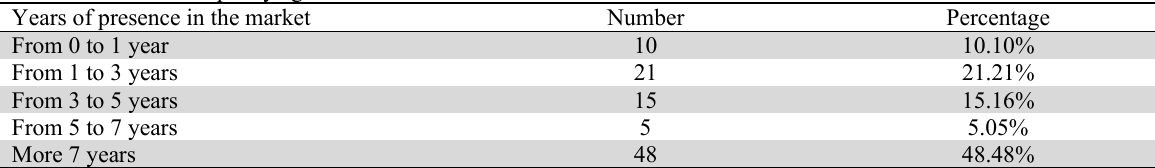
Distribution of the sample by age Years of presence in the